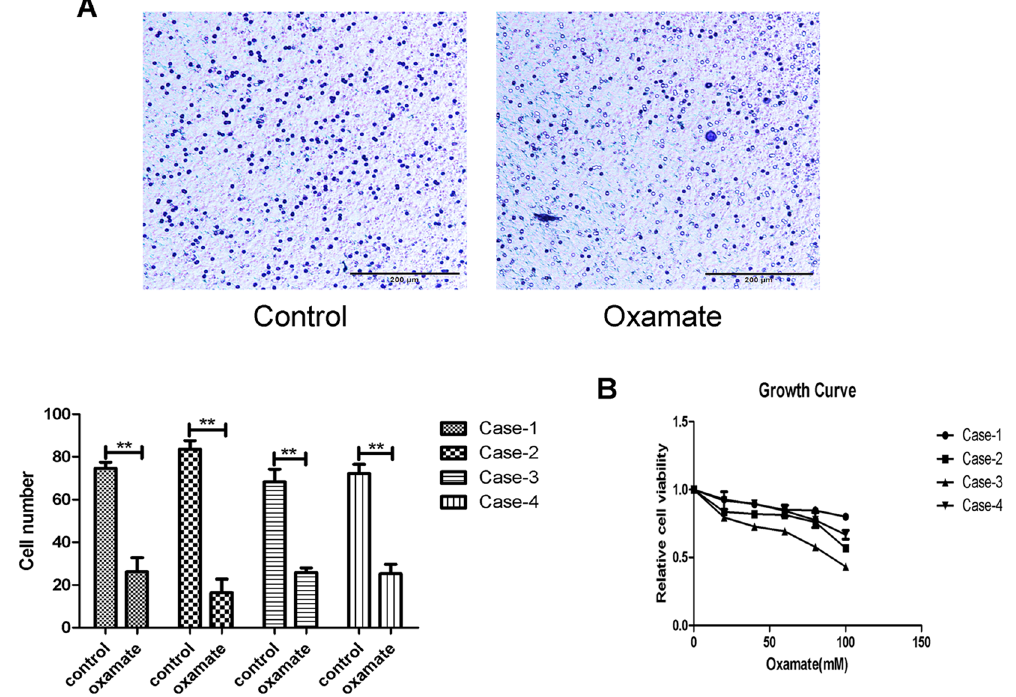
Figure 8. Oxamate suppressed cellular invasion and proliferation in primary cultures of human PA cells. ( A ) Detection of the primary cells invasion after untreated or treated with oxamate (40 mM) for 48 hours by transwell assay, Original magnification, × 100 (n = 5, ± SEM). ( B ) The effect of oxamate on proliferation of